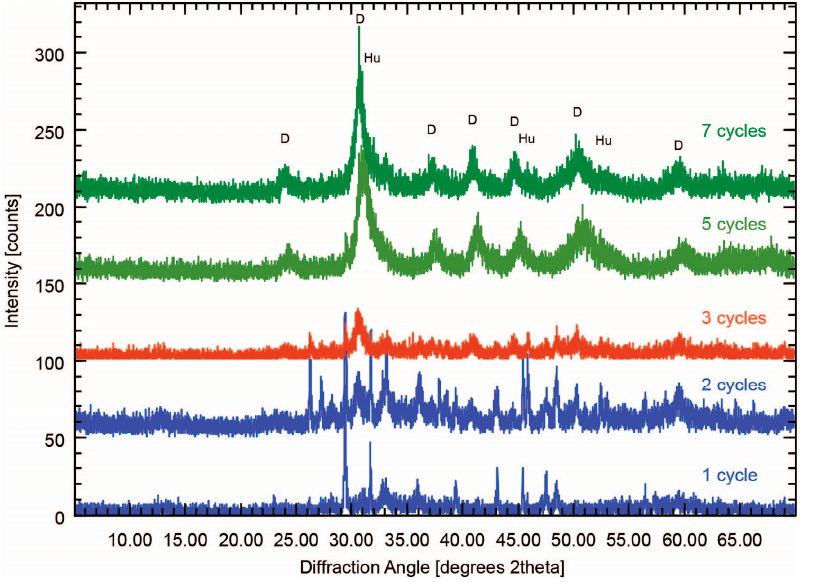
Figure 6. Powder X-ray diffractograms of reaction solids after 1, 2, 3, 5 and 7 diel cycles (each indicated by a different colour) in the second series of pH cycling experiments, which contain zinc ions. First, some original calcite dissolves and aragonite, hydrozincite and high magnesium calcite form. Subsequently, the reaction product is high magnesium calcite (D) and huntite (Hu).